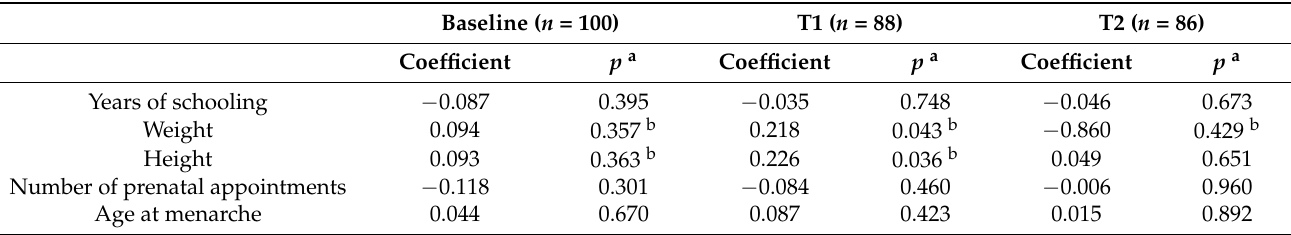
Table 3. Correlation between THB and independent